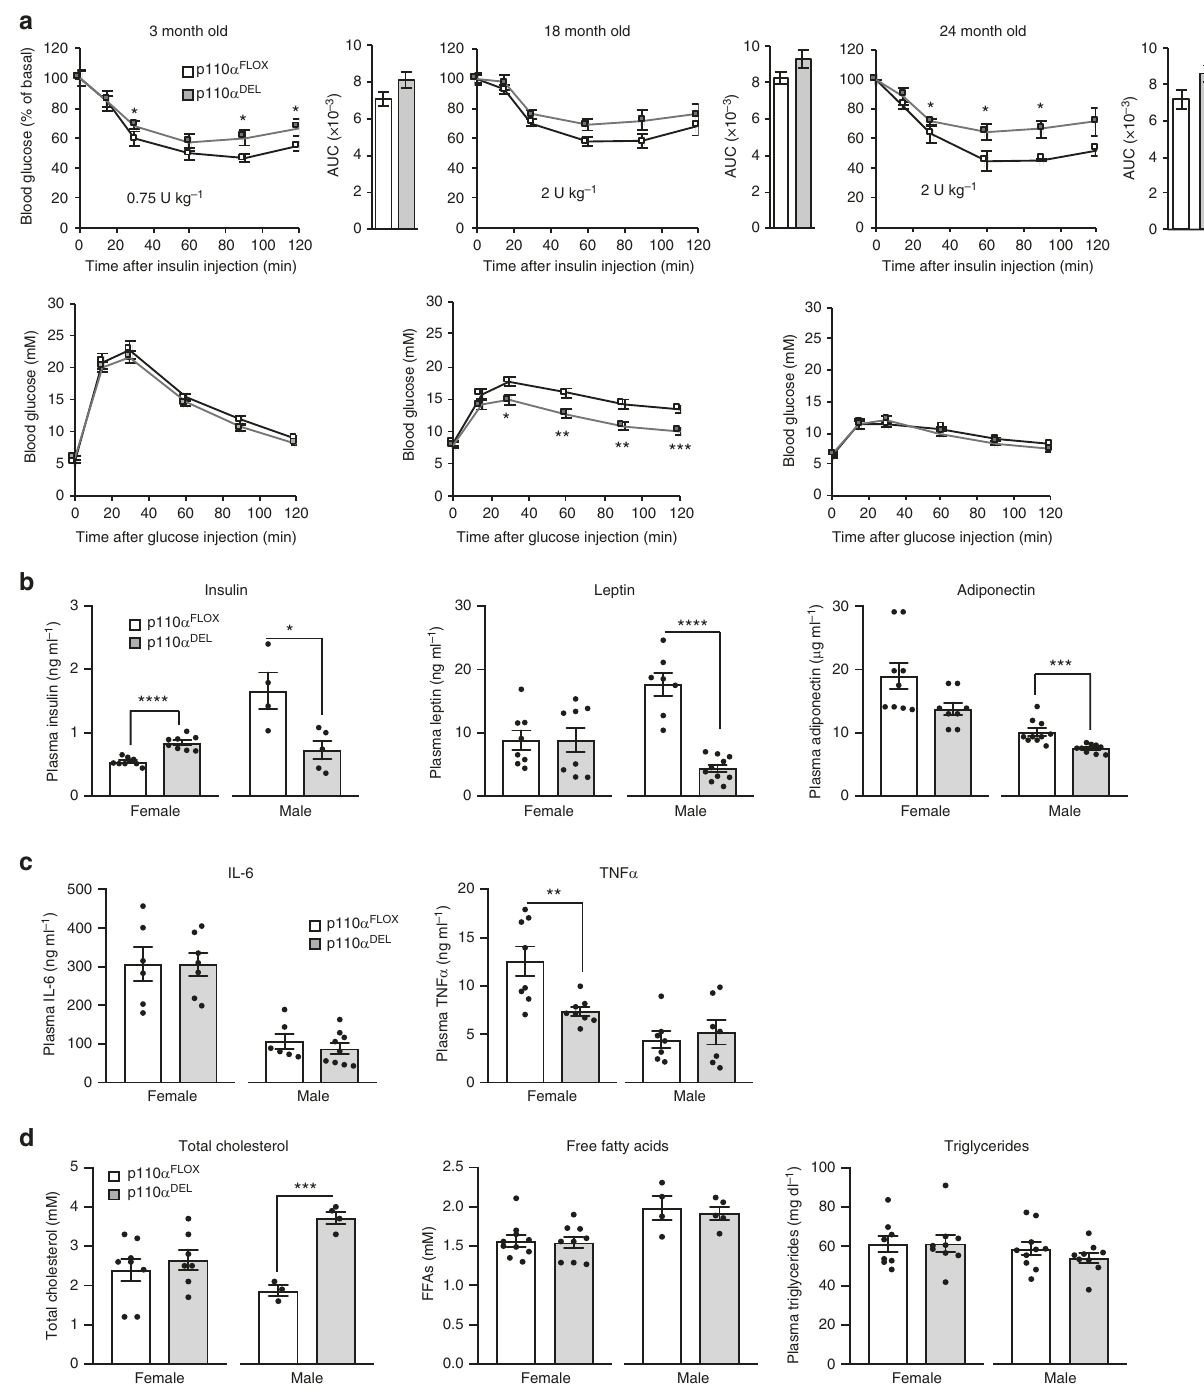
Fig. 2 Insulin resistant p110 α DEL mice maintain normal glucose tolerance over ageing. a Cohorts of p110 α DEL and p110 α FLOX male mice were subjected to intraperitoneal glucose and insulin tolerance tests at various time points over ageing. For glucose tolerance test a bolus of glucose (2 g per kg of body weight) was injected intraperitoneally. Insulin doses were adjusted according to the age of the mice (0.75 U kg − 1 for 3-month-old and 2 U kg − 1 for 18- and 24-month-old). n = 8 per genotype at 3 months, 16 per genotype at 18 months, 14 per genotype at 24 months. AUC, area under curve. Additional age points and data for females are shown in Supplementary Fig. 3. b Fasting plasma levels of metabolic hormones in 1-year-old p110 α DEL and p110 α FLOX mice. n (p110 α FLOX /p110 α DEL ), Insulin: Female, 9/8; Male, 4/5. Leptin: Female, 8/8; Male, 7/10. Adiponectin: Female, 8/8; Male, 10/10. c Fasting plasma levels of pro-in fl ammatory cytokines (IL6 and TNFa) in 1-year-old p110 α DEL and p110 α FLOX mice. n (p110 α FLOX /p110 α DEL ), IL-6: Female, 6/7; Male, 6/9. TNF α : Female, 8/8; Male, 7/7. d Fasting plasma levels of lipids (total cholesterol, free fatty acids and triglycerides) in 1-year-old p110 α DEL and p110 α FLOX mice. n (p110 α FLOX /p110 α DEL ), Cholesterol: Female, 8/7; Male, 3/4. FFAs: Female, 10/9; Male, 4/5. Triglycerides: Female, 8/9; Male, 10/9. Data are presented as mean ± SEM. Statistical analyses: Unpaired two-tailed t test. * p < 0.05; ** p < 0.01; *** p < 0.001; **** p <